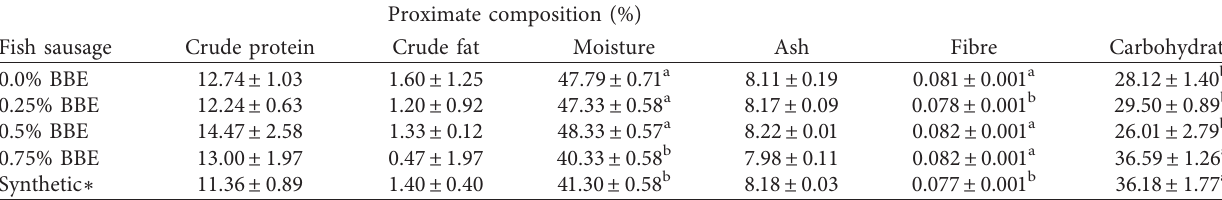
Table 2: Proximate composition of fish sausages fortified with different percentage of bee bread extract (BBE) and positive control. Proximate composition (%) Fish sausage Crude